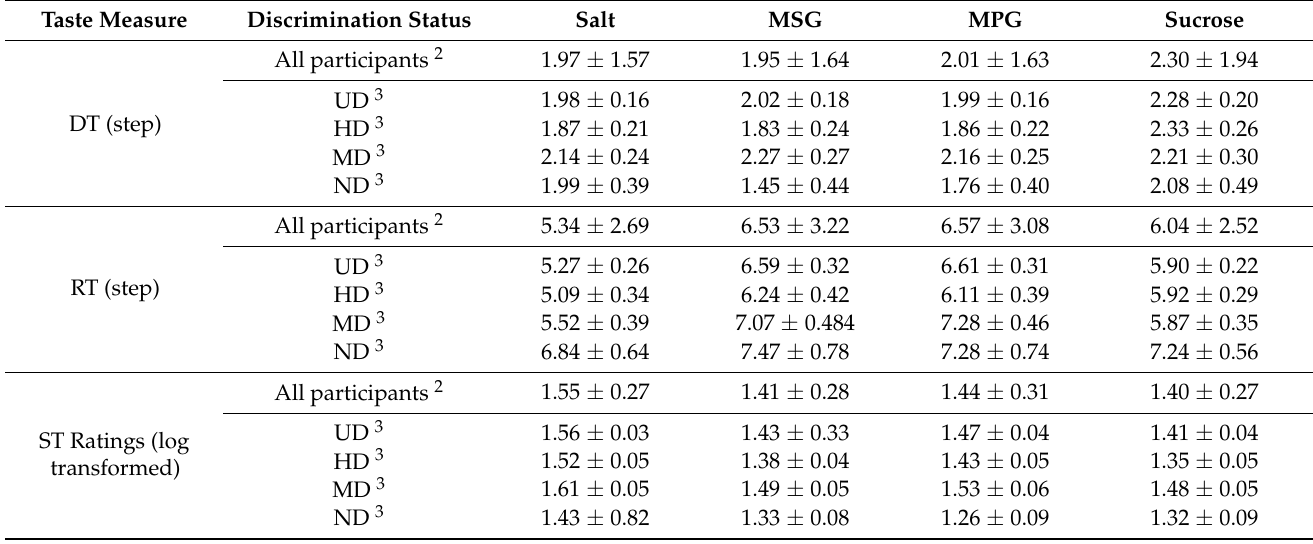
Table 2. Mean taste dimension measures (DT, RT, and ST) for salt, MSG, MPG, and sucrose assess- ments, split by discrimination status 1